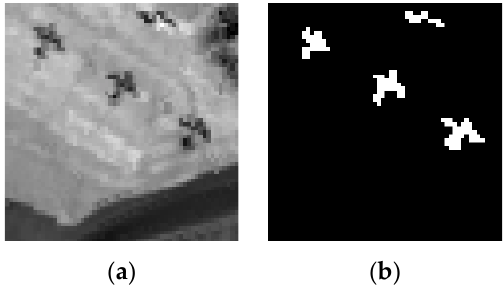
Figure 9. ( a ) San Diego airport dataset; ( b ) Ground truth map.